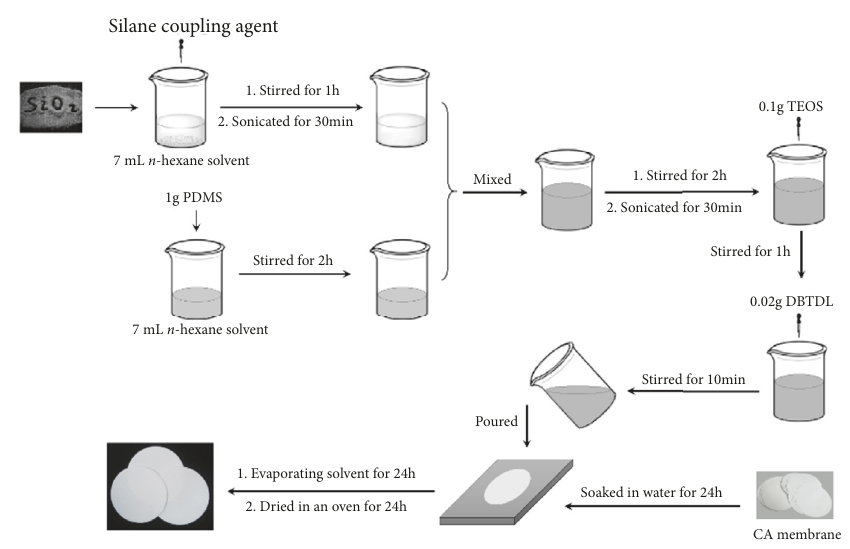
Figure 1: Schematic of preparation of hybrid